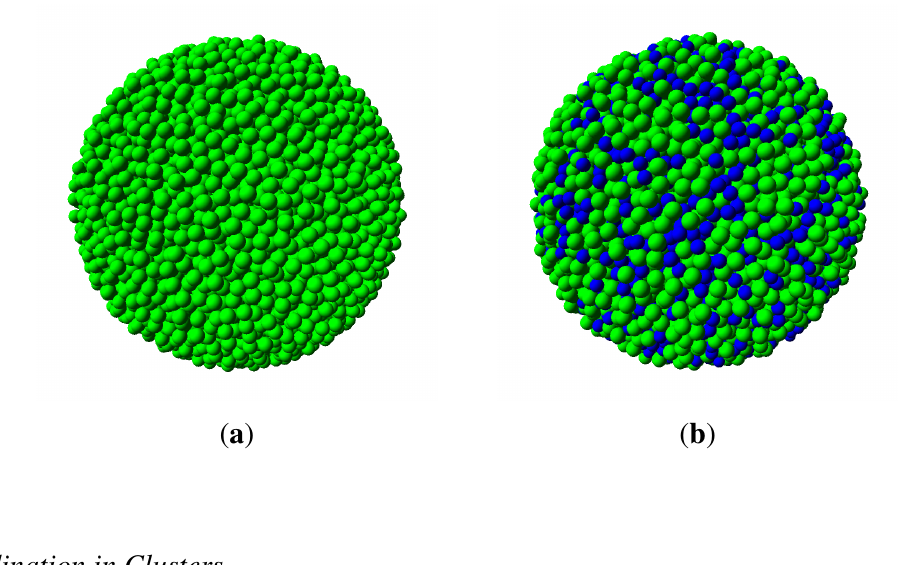
Figure 13. Monoatomic models of IAS. On left, a model comprising one type of spheres only. On right, a model with two types of spheres; blue spheres are 20% smaller than the green spheres. Each model contains 10 4